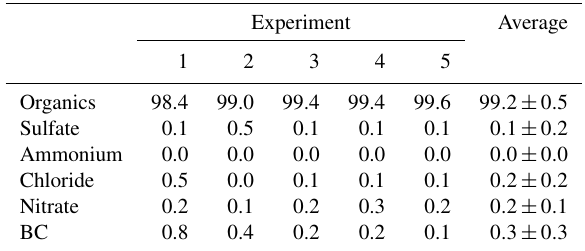
Table 2. Composition (% mass) of the freshly emitted COA for the laboratory